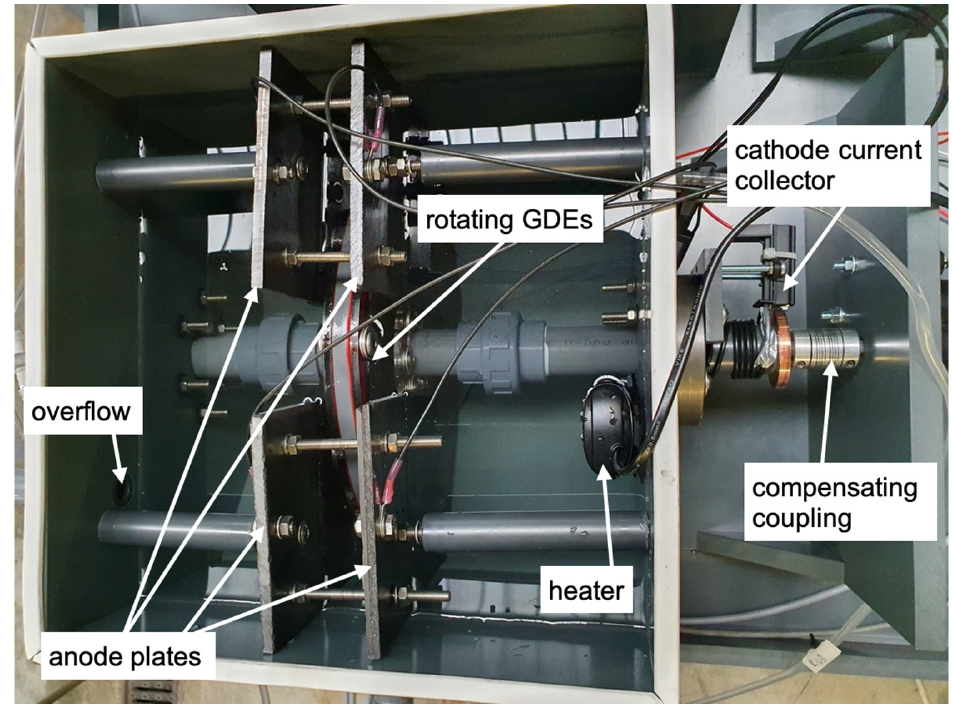
Figure 2. Reactor set-up, filled with tap water for tightness testing (view from